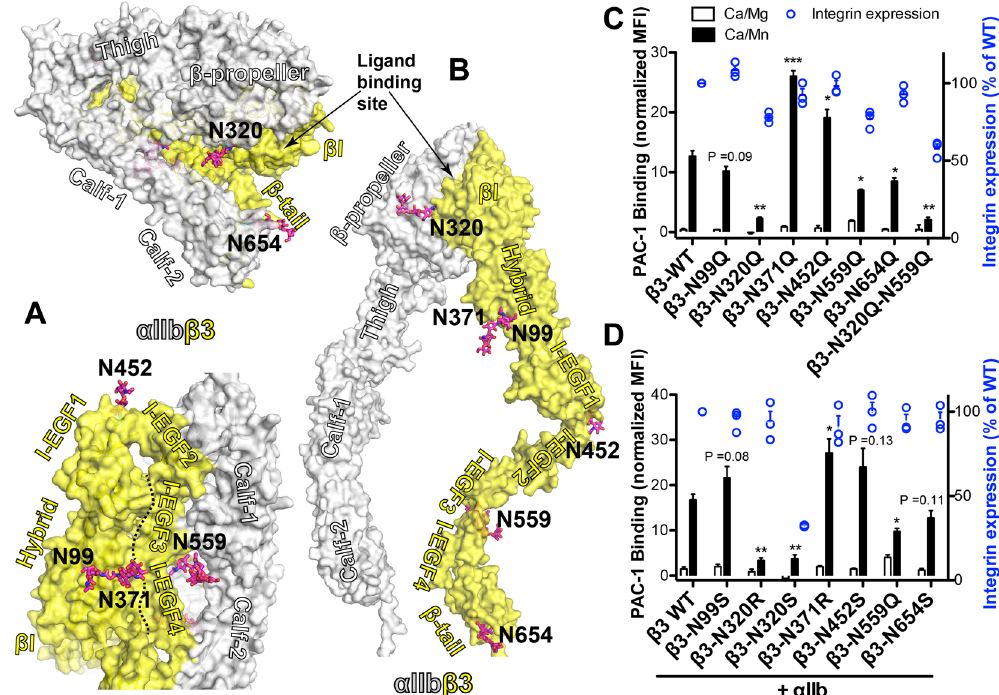
Figure 3. Effect of the individual N-glycan deletion of β 3 subunit on α IIb β 3 ligand binding. (A) Locations of the β 3 N-glycan sites in the crystal structure of α IIb β 3 (PDB code 3FCS) at the bent conformation shown as the solvent accessible surface in two views. The boundary of the hybrid/I-EGF3-4 domain interface is indicated as a black dotted line. (B) Model of the high affinity extended conformation of α IIb β 3 . Asn residues are shown as sticks with carbons in cyan. N-glycan groups resolved in the crystal structure are shown as sticks with carbons, oxygens, and nitrogens in magenta, red, and blue, respectively. (C , D) Ligand-mimetic mAb PAC-1 binding of the indicated single mutations of β 3 co-expressed with α IIb in HEK293FT cells in the presence of 1 mM Ca 2 + / Mg 2 + (Ca/Mg) or 0.2 mM Ca 2 + plus 2 mM Mn 2 + (Ca/Mn). PAC-1 binding was measured by flow cytometry and presented as mean fluorescence intensity (MFI) normalized to integrin expression (AP3 binding). Data are means ± s.e.m. (n ≥ 3). Two-tailed t-tests were used to compare the wild type (WT) and the mutants in the Ca/ Mn condition. * P < 0.05; ** P < 0.01; *** P <